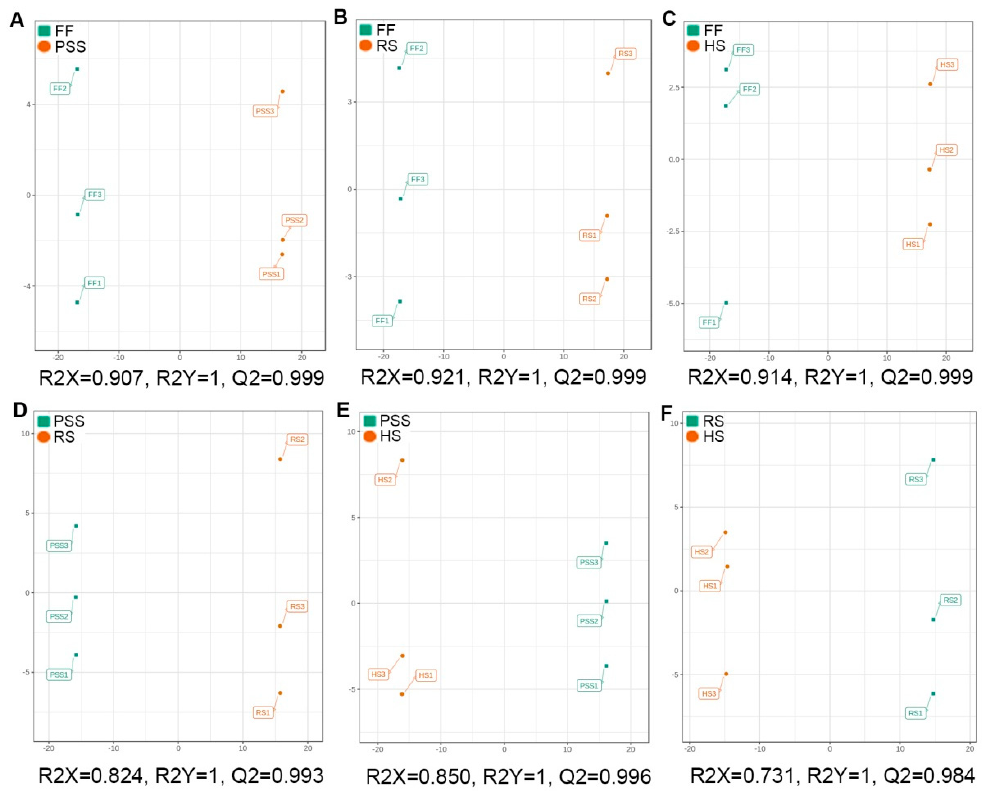
Figure 4. Score plots of orthogonal partial least squares discriminant analysis (OPLS-DA) for six pairwise comparisons. R2X and R2Y were cumulative modeled variation of all R2Xs and R2Ys, separately, and Q2 was the cumulative predicted fraction. The abbreviated stage name and observation dates were the same as described in Figure 3. ( A ) PSS vs FF; ( B ) RS vs FF;( C ) HS vs FF;( D ) PSS vs RS;( E ) PSS vs HS;( F ) RS vs HS.